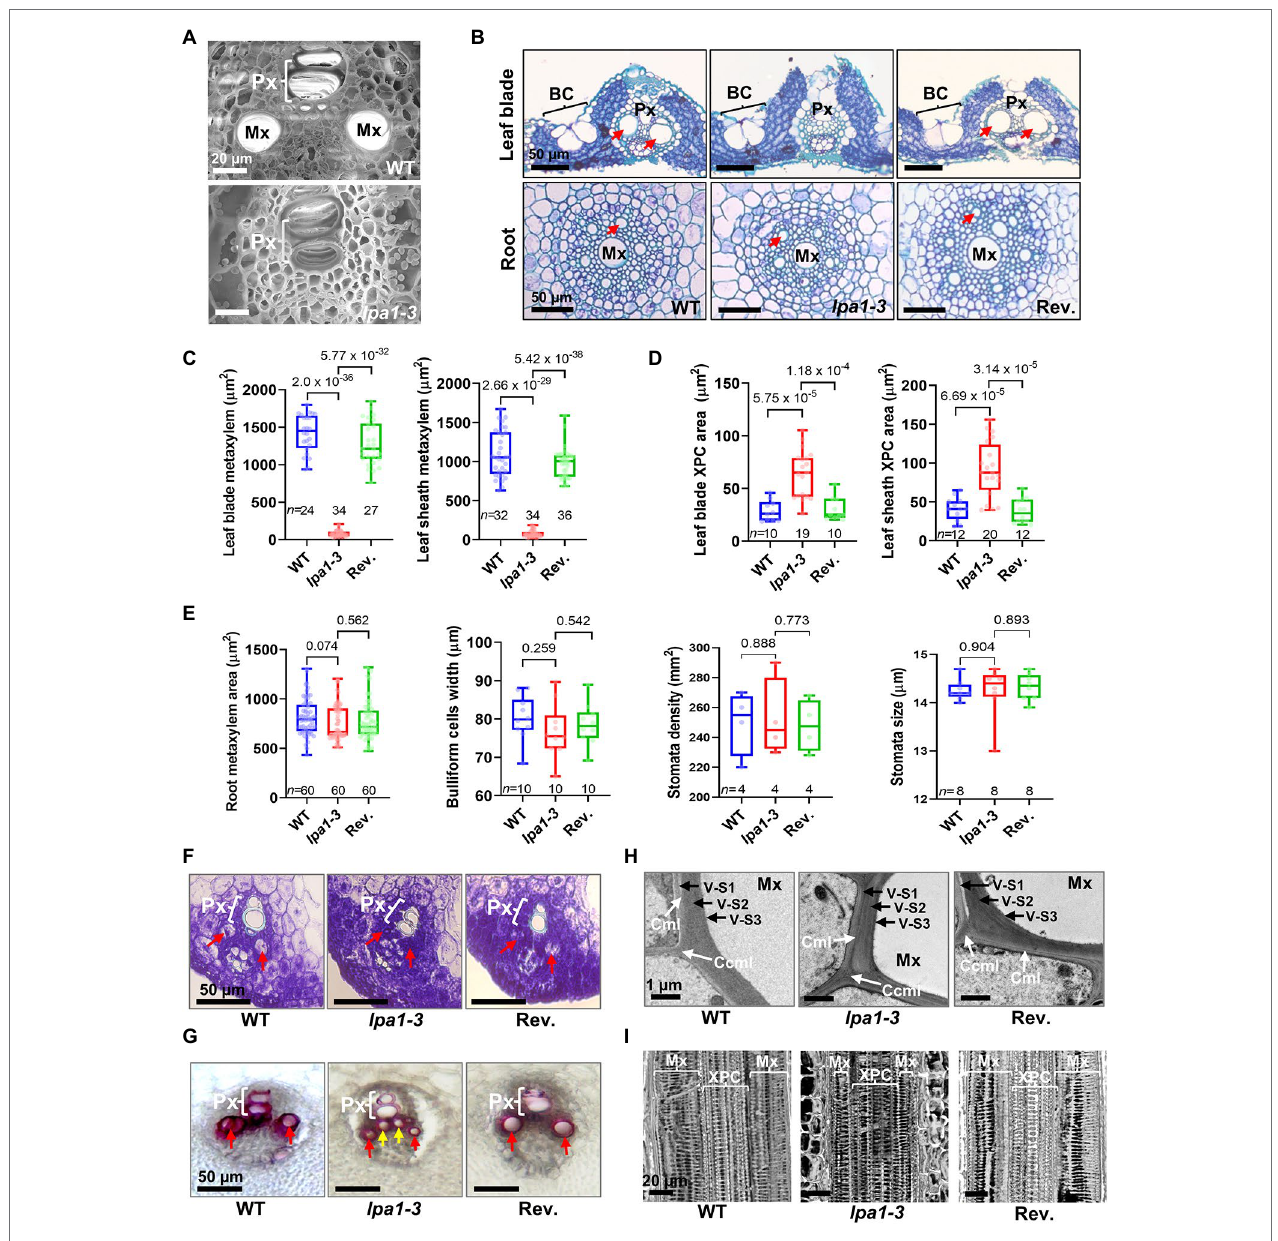
FIGURE 2 | Anatomical analysis of metaxylems in leaf vasculatures of lpa1-3 . (A) Scanning electron microscope images of vasculature in WT (top) and lpa1-3 (bottom). (B) Cross sections of leaf blades (top) and roots (bottom) in WT, lpa1-3 , and the revertant (Rev.). (C,D) Quantification and comparison of metaxylem (Mx) areas (C) and xylem parenchyma cell (XPC) areas (D) of leaf blades (left) and leaf sheaths (right). (E) Quantification and comparison of root metaxylem areas (left), bulliform cell (BC) widths (middle left), and stomata densities (middle right) and sizes (right). (F) Cross sections of vasculature in fifth leaf primordia to show the developing metaxylem. (G) Lignin staining of vasculature on the cross sections of pulvini tissues. (H) Transmission electron microscope images of secondary cell wall in mature metaxylem. White arrows indicate cell corner middle lamella (CCML) between adjoining fibers or compound middle lamella (CML). Mxv, metaxylem vessel; V-S1, outer secondary wall of vessel; V-S2, middle secondary wall of vessel; V-S3, inner secondary wall of vessel. (I) Internal 3D images of metaxylem and xylem parenchyma cells in leaf mid vein. Red arrows indicate metaxylem. Yellow arrows indicate xylem parenchyma cells. Px, protoxylem; For each box plot, the lower and upper bounds of the box indicate the first (Q1) and third (Q3) quartiles, respectively, the center line indicates the median. Values of p denoted on the graph, two- tailed, two-sample t -test. n , number of replicates. Scale bars are indicated in each